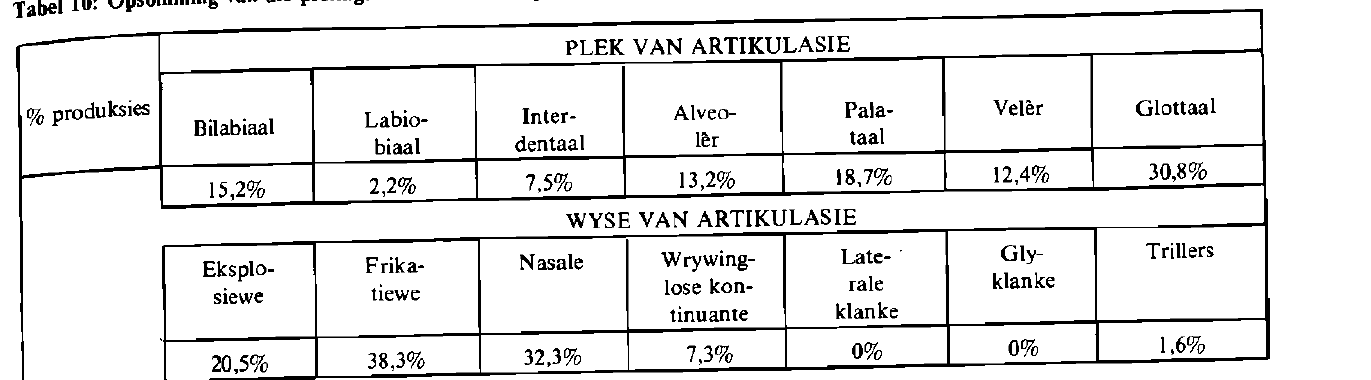
Tabel 11 verskaf 'n oorsig van die proefpersone se vokaal- produksies en hiervolgens blyk dit dat die plek van vokaal- produksie ooreenstem met die van normale ontwikkeling. Verder